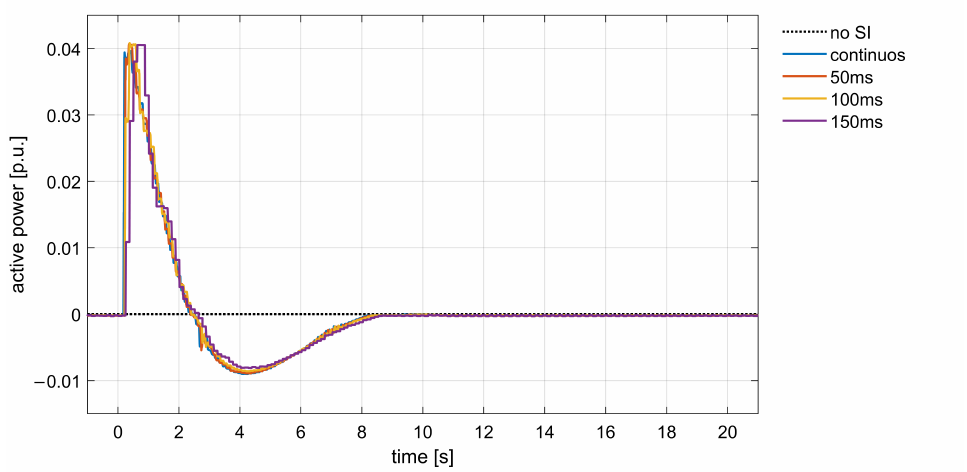
Figure 9. Ideal controller: BESS active power response with different RoCoF reporting time and K =